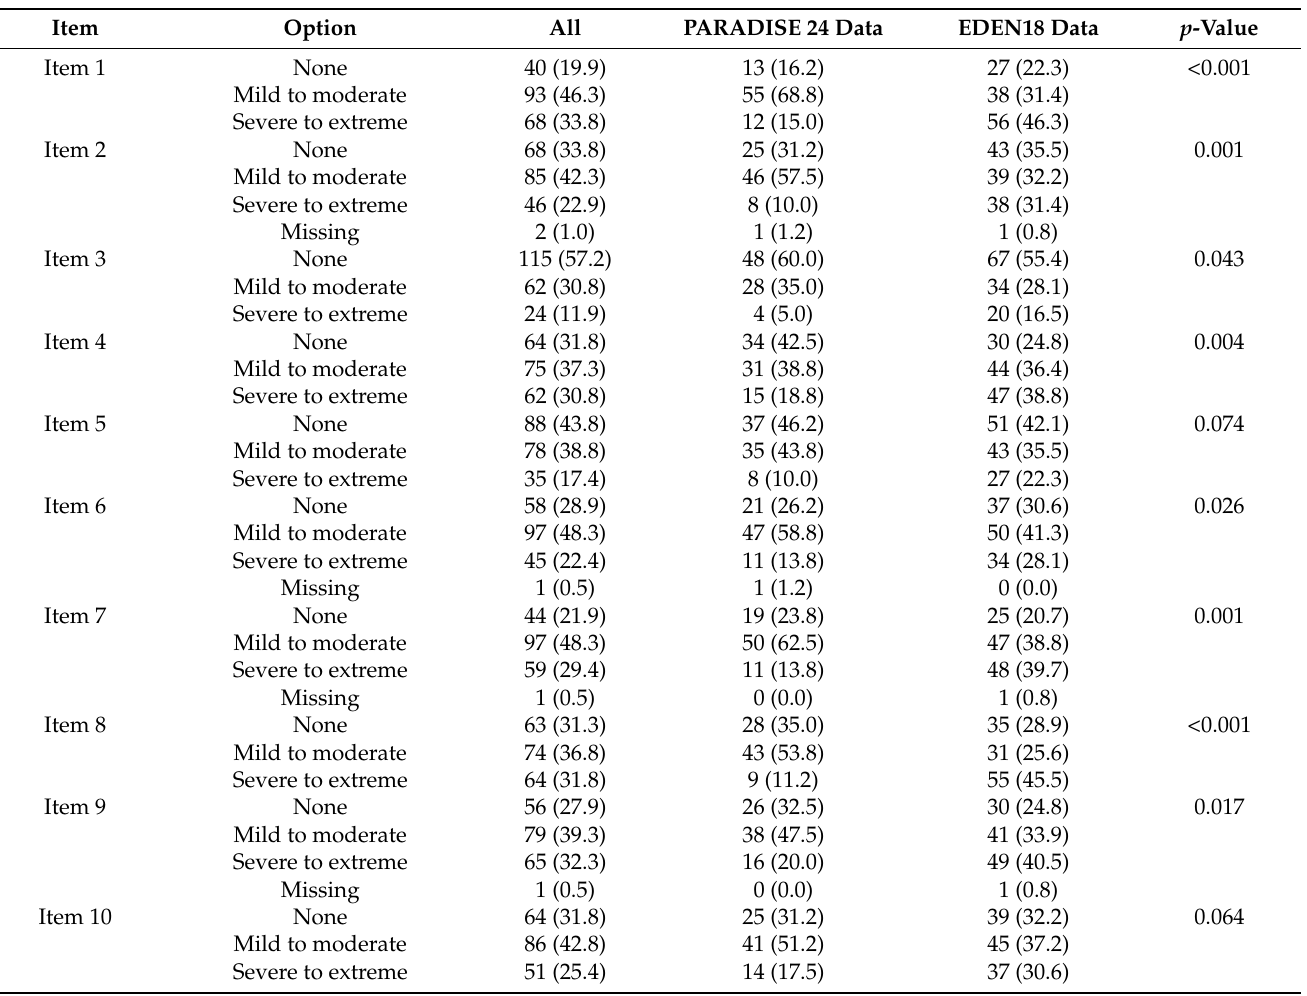
Table A1. Response frequencies (percentages) for all the selected items, the 24 Paradise items, and the 18 additional Eden items with significance test on the response frequencies per item ( p